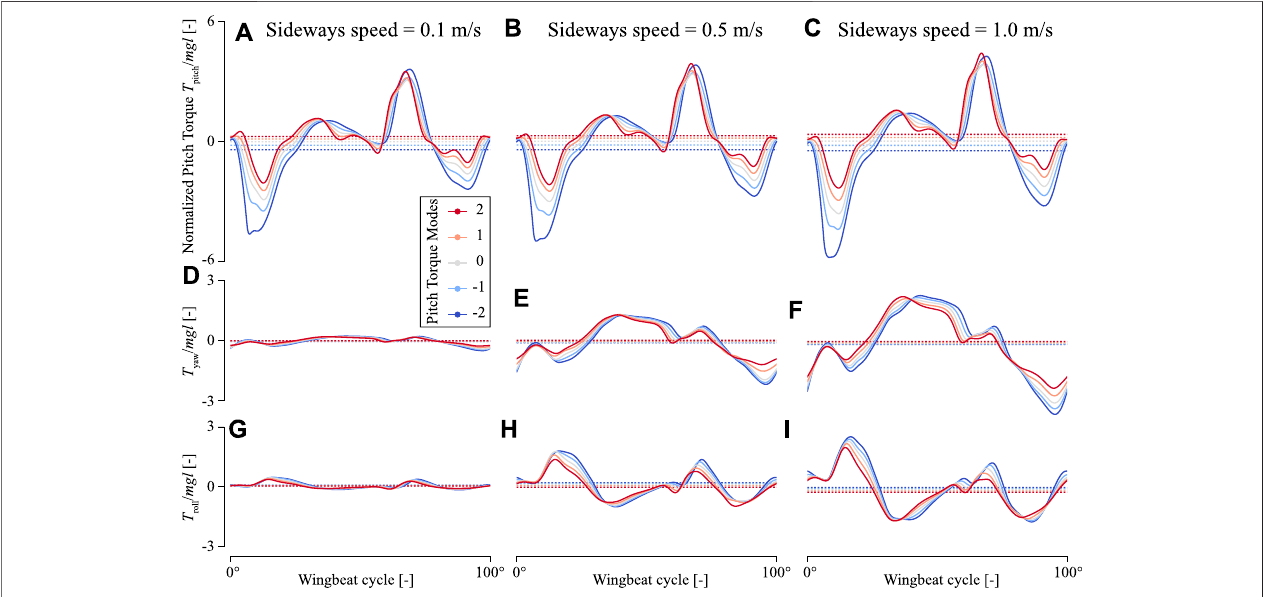
FIGURE 8 | Temporal dynamics of the torques produced by an in-silica fruit fl y fl ying sideways with variable pitch torque-producing wing-beat kinematics. (A – C) Pitchtorques (D – F) yawtorques,and (G – I) rolltorques,respectively.The fi rsttolastcolumnsshowtorquesproducedatasideways fl ightspeedof0.1,0.5,and1.0 m/s, respectively.EachpanelshowstorquesdeterminedusingCFD(ordinate)throughoutasinglewingbeatcycle(abscissa)forthevariouspitchtorque-producingwing-beat kinematics (color-code, see legend). The doted horizontal lines show the wingbeat-average torques. All torques are normalized with the order-of-magnitude of the weight and size of an average fruit fl y.